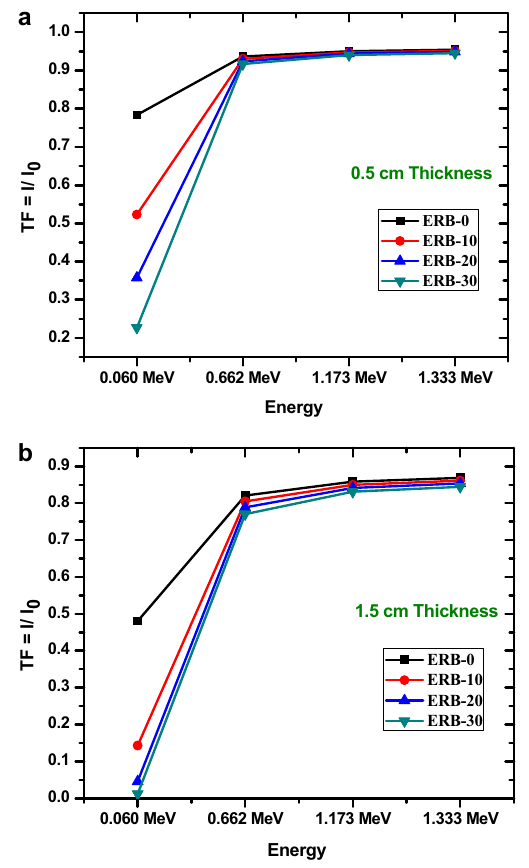
Figure 4. ( a ) The transmission factor for the prepared composites with thickness 0.5 cm. ( b ) The transmission factor for the prepared composites with thickness 1.5